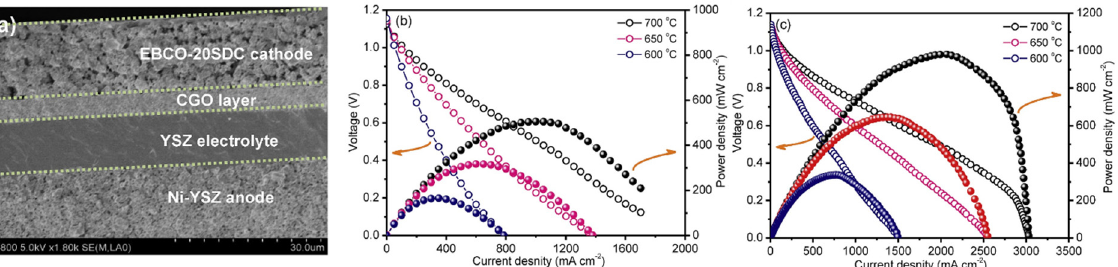
Figure 9. ( a ) Cross-section view of SEM micrograph of the Ni–YSZ|YSZ|CGO|EBCO–20SDC cell. The V – I and P – I curves of the Ni–YSZ|YSZ|CGO|EBCO– x SDC cells from 873 K to 973 K at ( b ) x = 0 and ( c ) x =20 (adopted with permission from [165]. Copyright 2019, Elsevier). Idrees et al. [168], using a facile and effective one-pot sol-gel method, prepared a PrBa 0.92 Co 2 O 6– δ –40 wt.%Ce 0.8 Sm 0.2 O 1.9 (OPCC) composite cathode material and compara-